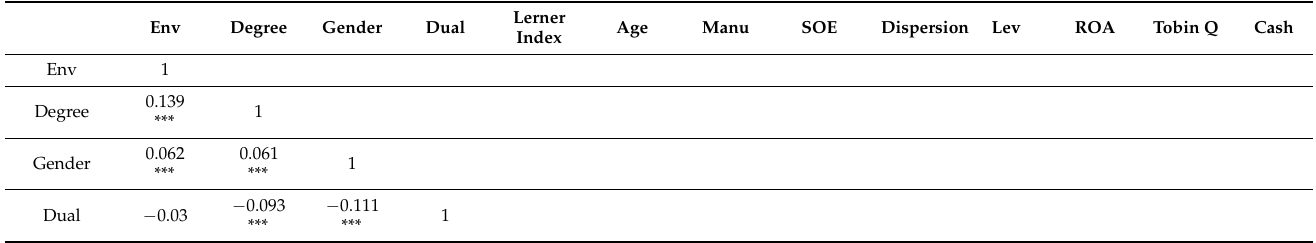
Table 3. Pearson correlation